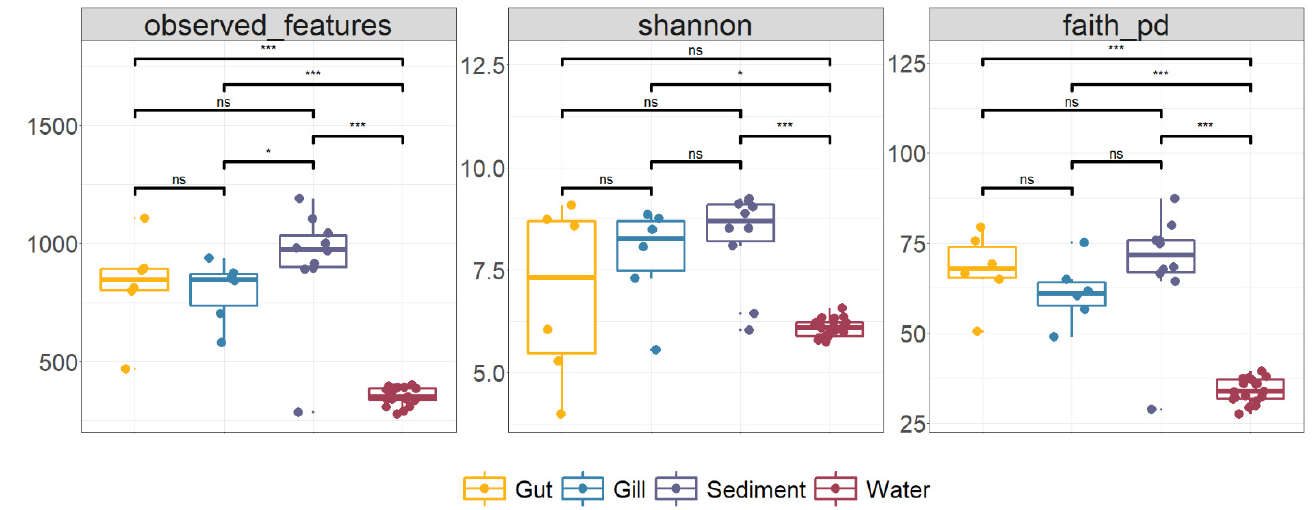
Figure 1. Boxplots of the alpha diversity index of the microbiota between largemouth bass and environment in the IPRS. The middle line of the box represents the median, and the upper and lower boundaries of the box represent the third quartile and the first quartile, respectively. The upper and lower whisker boundaries represent the maximum and minimum values, respectively, excluding any outliers. Dots represent values. Bracketed lines and values represent the differences between the two groups. ns, p > 0.5, *, p ≤ 0.5, ***, p ≤ 0.001.